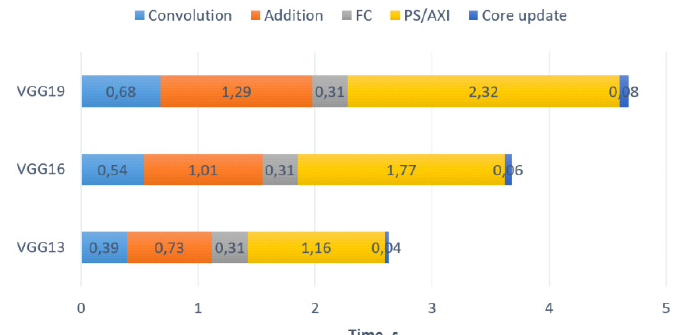
Figure 14. The distribution of processing time of VGG networks implemented with mNet2FPGA CNN core.